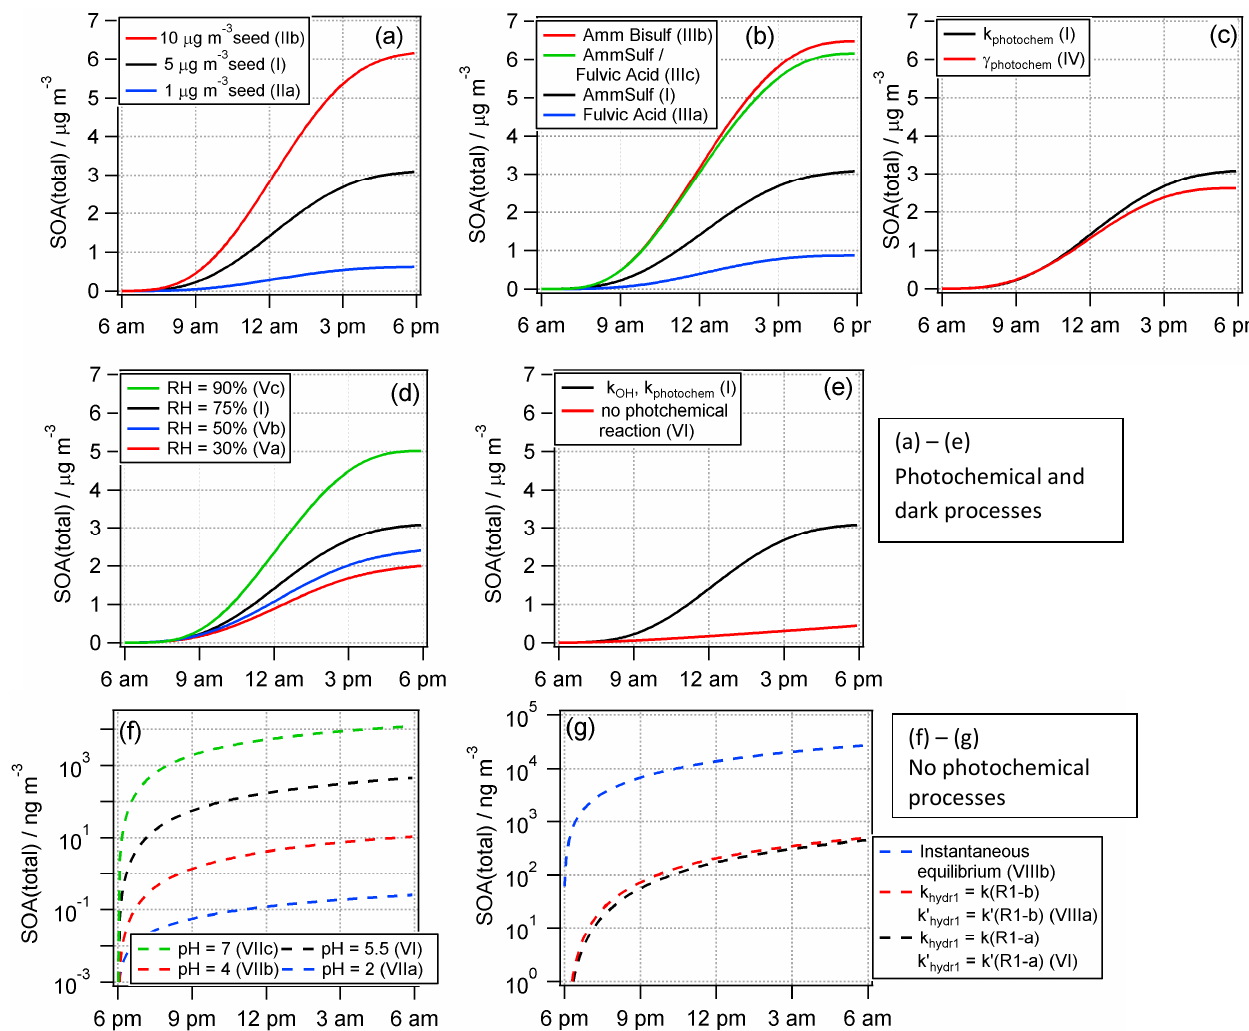
Fig. 6. Predicted SOA masses over a simulation time of 12h for the conditions in Table 7. The model to predict SOA masses (a–e) [µgm − 3 ]; (f, g) [ngm − 3 ] includes all processes in Table 2. The black line depicts the base case (solid line: including photochemical processes; dashed line: only dark processes). Dependence of predicted SOA masses from glyoxal (300ppt; constant over the simulation time) on (a) seed mass, (b) aerosol composition, (c) bulk vs surface process, (d) relative humidity, (e) day/night time chemistry, (f) pH; note that the assumption of pH=7 in the empirical equation (Reaction R8, Table 2) leads to unrealistically high predicted SOA masses. (g) assumptions on hydration kinetics (rate constants: cf Table 2); note that the assumption of instantaneous hydration equilibrium leads to unrealistically high predicted SOA masses. The results in (f) and (g) explore only SOA formation during night time and are shown on a logarithmic